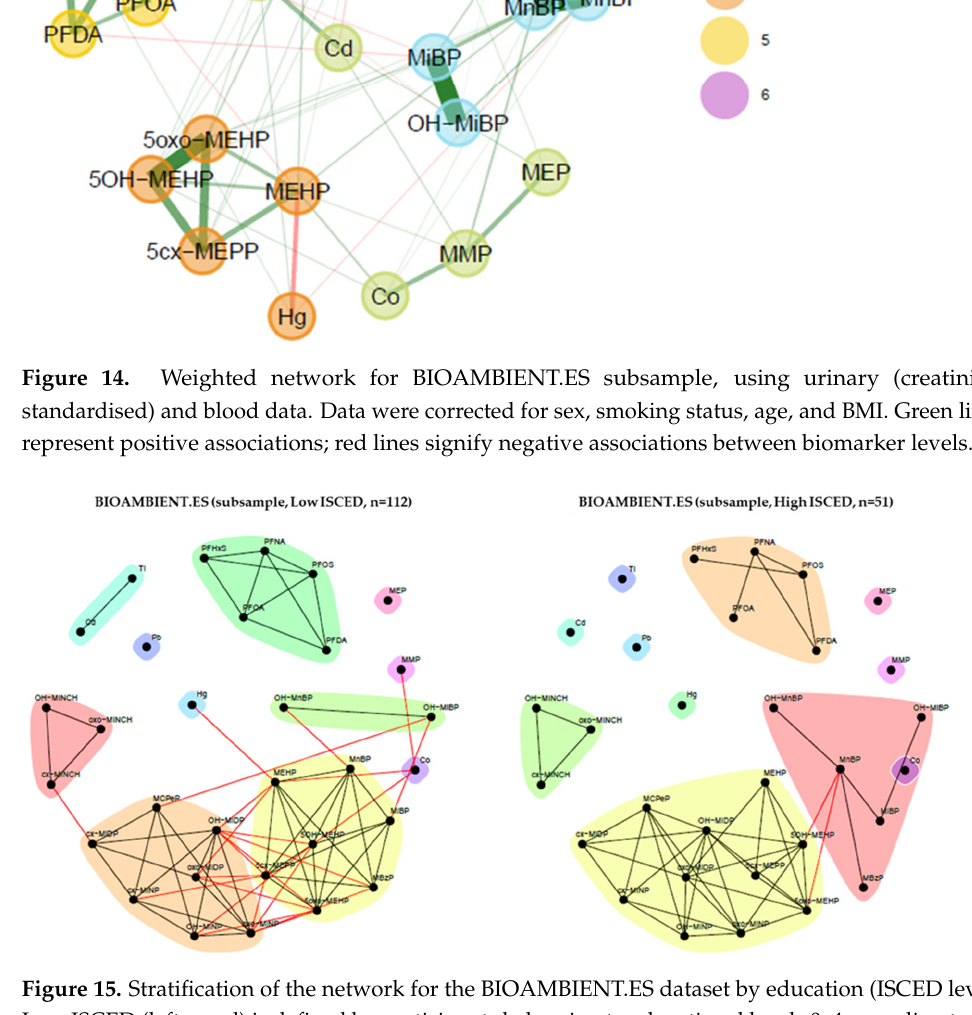
Figure 16. Stratification of the network for the BIOAMBIENT.ES subsample by BMI. Unweighted network for participants with a normal weight (defined as BMI < 25) is shown in the left panel, while the network for participants with overweight (BMI ≥ 25) is shown in the right panel. Data were corrected for sex, age and smoking status. Black lines indicate dependency between nodes (bi- omarkers) within a community; red lines indicate dependency between nodes in different commu- nities.